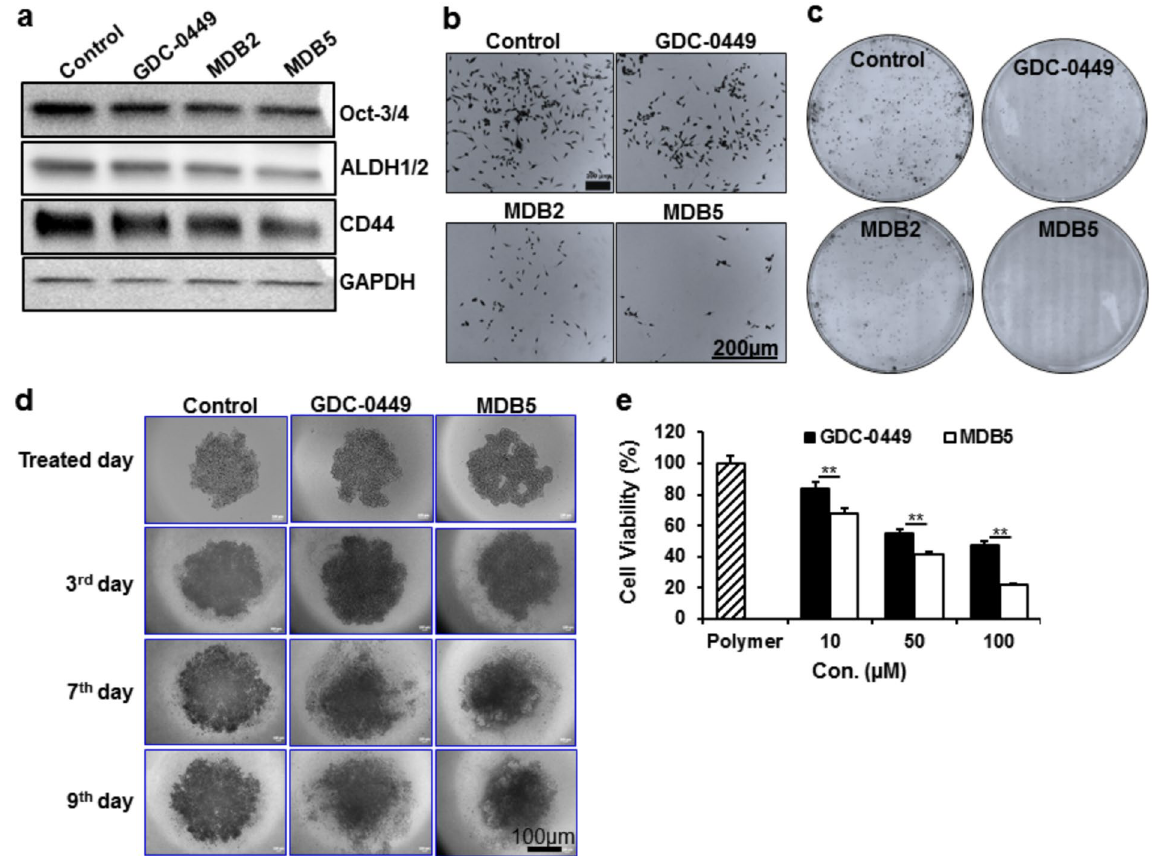
Figure 6. ( a ) Western blot analysis of pancreatic CSC markers in MIA PaCa-2 cells after GDC-0449 and MDB5 treatment. ( b ) Effect of GDC-0449 and MDB5 on MIA PaCa-2 cells motility. (c) Effect of GDC-0449 and MDB5 on colony formation of MIA PaCa-2 cells. ( d ) Effect of GDC-0449 and MDB5 on 3D spheroid of MIA PaCa-2 cells. ( e ) Cell cytotoxicity assay of MIA PaCa-2 cells treated with GDC-0449 and MDB5 containing nanoparticles. Percentage of viable MIA PaCa-2 cells was estimated by MTT assay. Data are shown as the mean ± S.D. of three separate experiments (Student t-test; * p < 0.05 ; ** p < 0.001 ; n = 3 ). Cropped Western blots are shown. Full-length Western blots are included in the Supplementary Information (Fig.